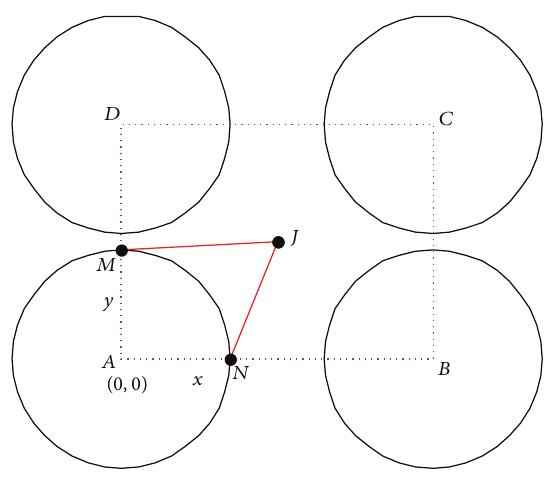
Figure 3: Case 1: relationship between 𝑥 and 𝑦